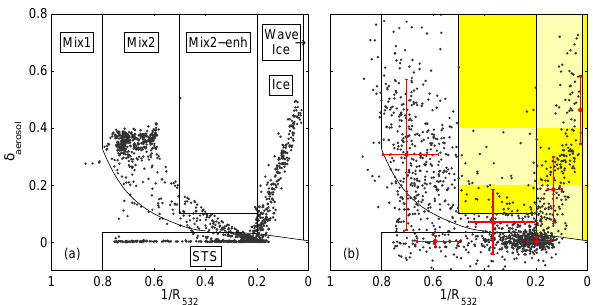
Fig. 3. Simulated model results for an exemplary CALIPSO orbit. Results are shown within the 2-D scatter plot of aerosol depolariza- tion ratio ( δ aerosol ) versus inverse backscatter ratio (1 /R 532 ). (a) Unperturbed model results. (b) Model results with CALIOP un- certainties ( σ ) applied. Uncertainties in parallel and perpendicular backscatter are calculated using Eq. (7), propagated into δ aerosol and 1 /R 532 , and shown as red error bars. Yellow boxes denote a divi- sion of the particle classes Mix2-enh, ice and wave ice to quantify the performance of different model runs as discussed in Sect.3.